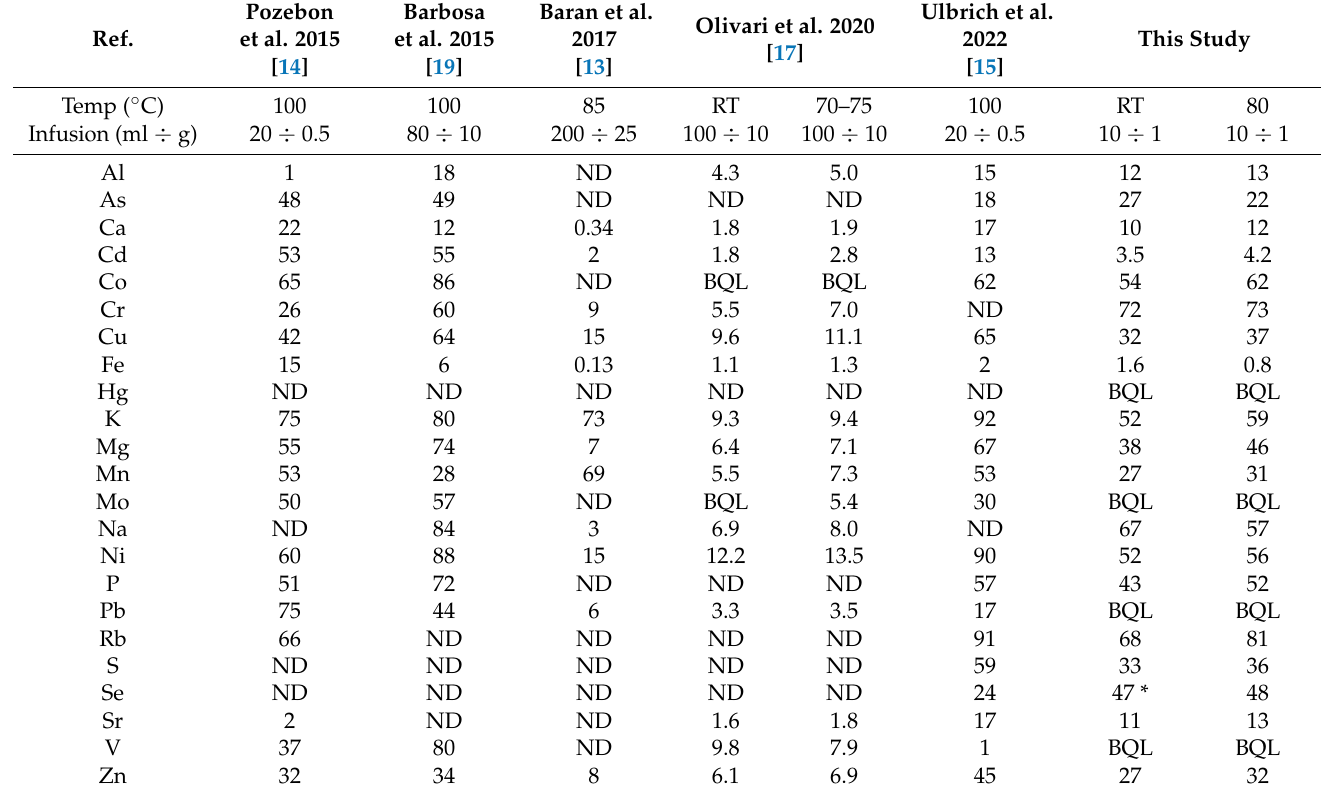
Table 5. Extractable content with deionized water (as % of total content, mean) compared between this study and the literature